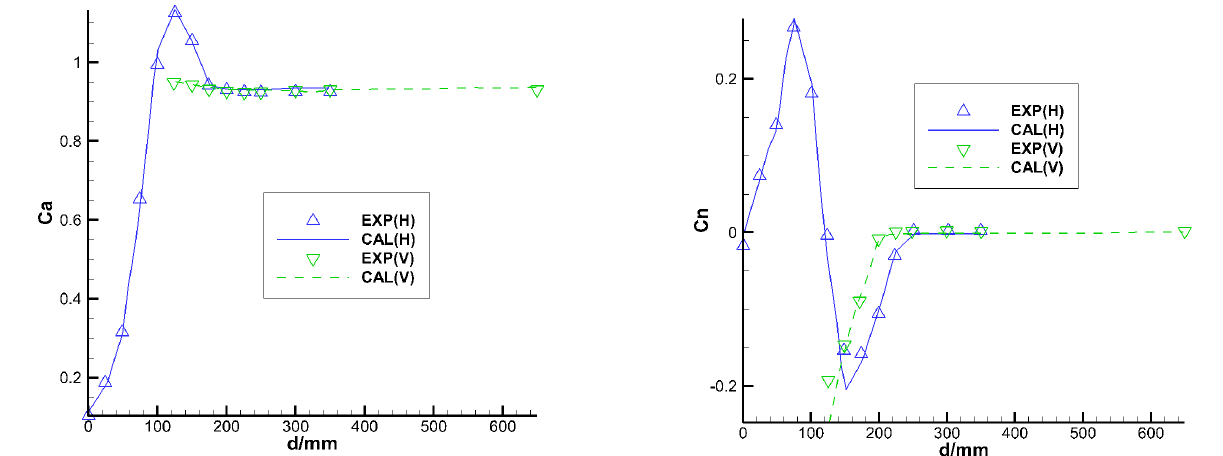
Figure 9. Comparison on aerodynamic coefficients of interfered spherocylinder and sphere obtained by numerical simulation and experiment.